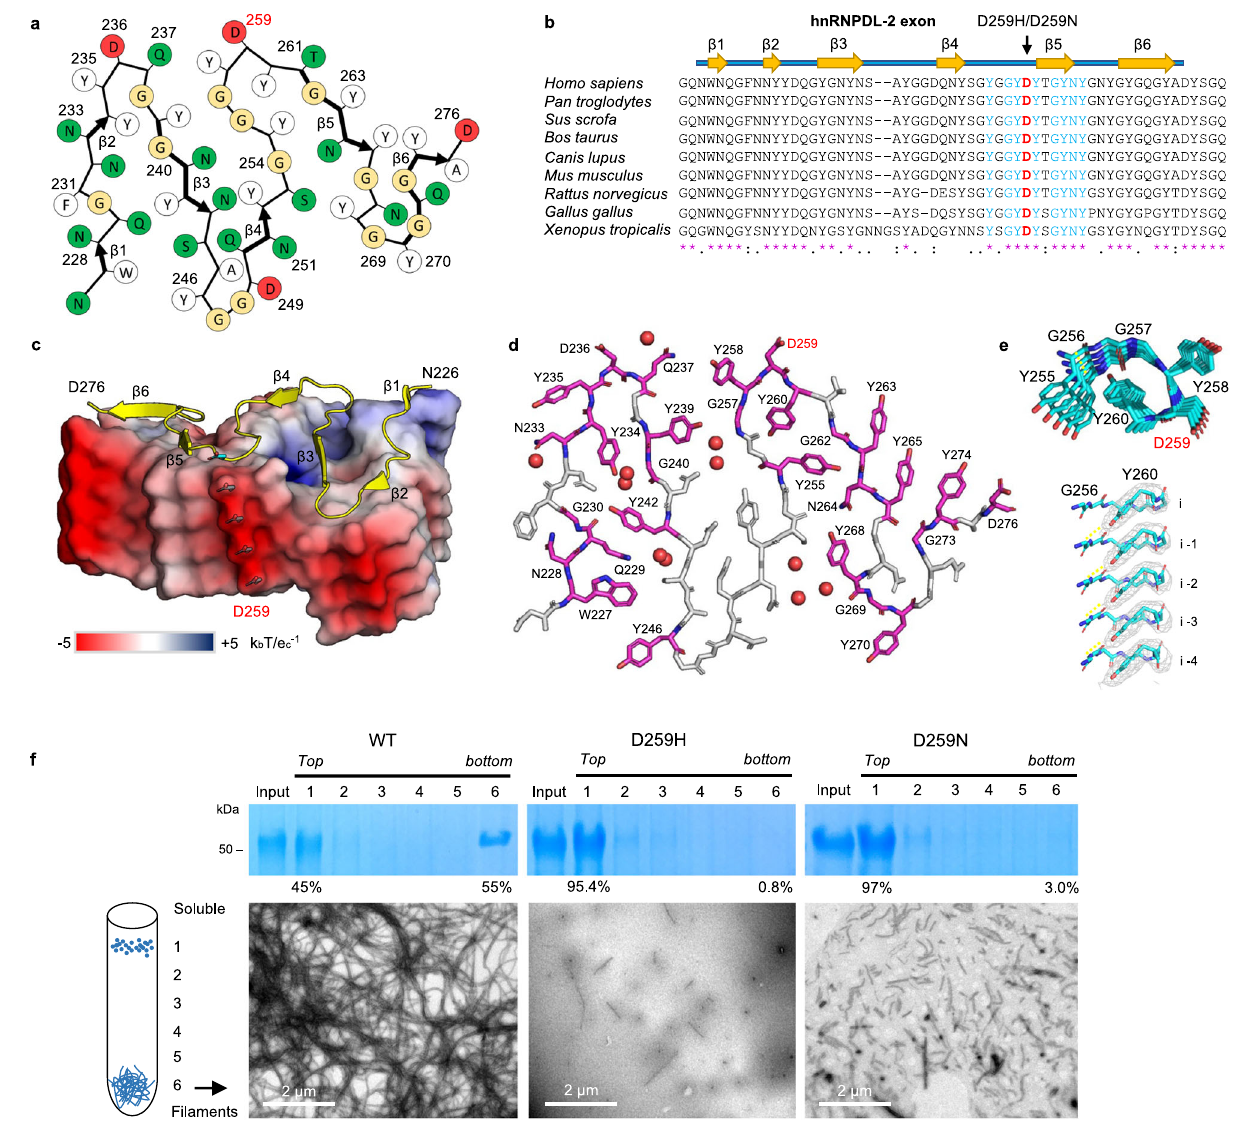
Fig. 3 | Overall structure of the hnRNPDL-2 fi bril core. a Schematic representa- tionofonecross-sectionallayerofthehnRNPDL-2 fi brilcore.Thelocationofthe β - strands is indicated with thicker arrows. Polar and hydrophobic residues are colored in green and white, respectively. Glycine residues are colored in yellow. Aspartic residues are colored in red. b Sequence alignment of hnRNPDL ortholo- gues showing evolutionary conservation of residues within exon 6. The β -strands thatbuildthehnRNPDL-2 fi brilsamyloidcoreareindicated.ThemutatedD259and surrounding conserved residues are shown in red and blue, respectively. Con- servedresiduesareindicatedwithanasterisk. c Surfacerepresentationshowingthe electrostatic surface potential of the hnRNPDL-2 fi bril at pH 7, with ribbon repre- sentationofonesubunitontop.Electrostaticpotentialmapswerecalculatedusing APBS server and visualized using the APBS plugin in PyMol (Schrödinger, NY, USA) 52,59 . Negative and positive map potential values are colored in red and blue, respectively,accordingtothek b Te c − 1 unitscale(k b istheBoltzmann ’ sconstant,e c is